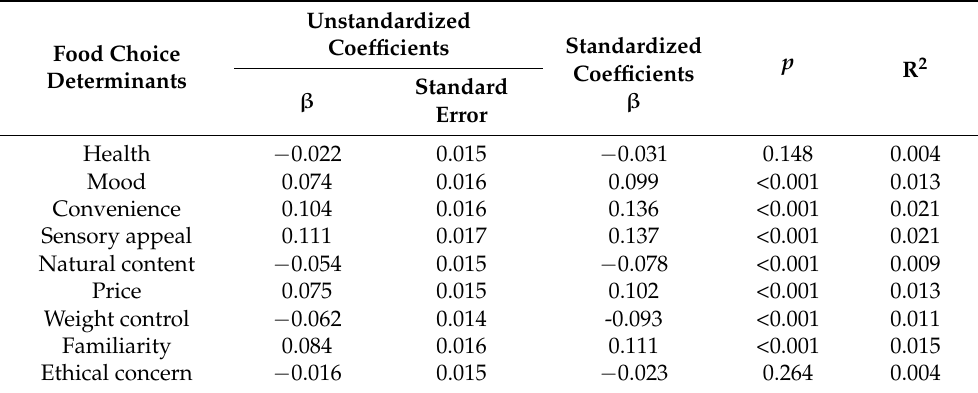
Table 7. Analysis of association between food choice determinants assessed by Food Choice Question- naire (FCQ) and snacks preference assessed by Food Preference Questionnaire (FPQ) (model adjusted for sex and age) within the population of the second phase of the Polish Adolescents’ COVID-19 Experience (PLACE-19) Study ( n = 2341).